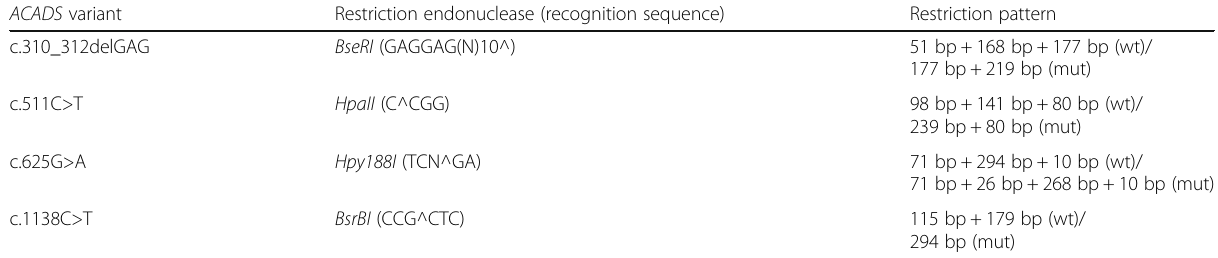
Table 2 Restriction endonucleases that were used with their palindromic recognition sequences and resulting restriction patterns ACADS variant